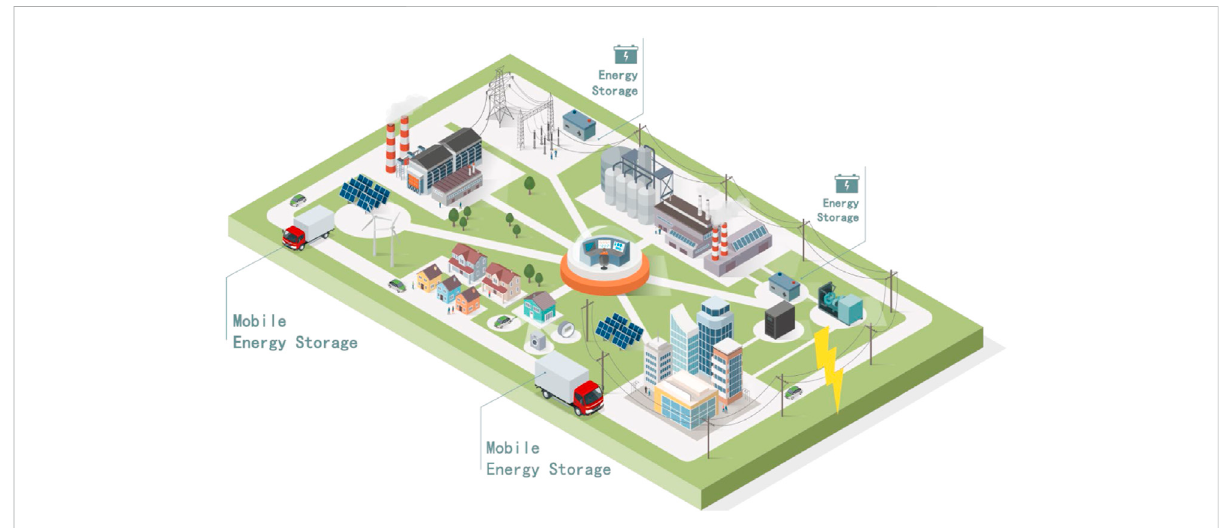
FIGURE 1 Schematic of the post-event network restoration scheme with the